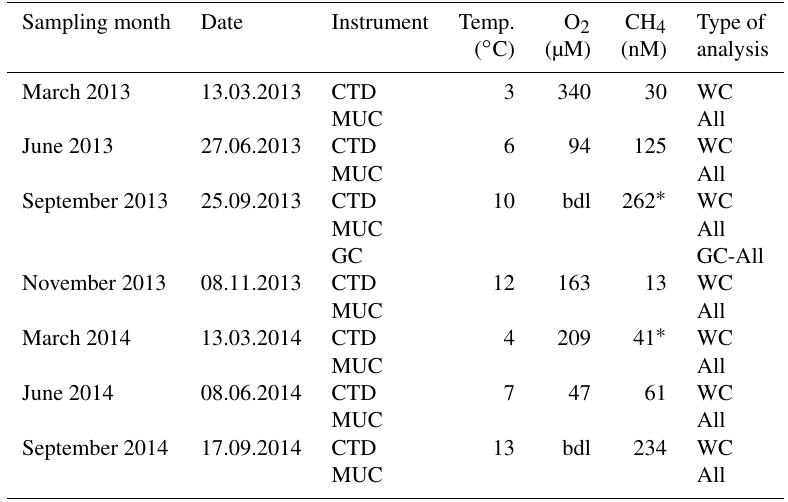
Table 1. Sampling months with bottom water ( ∼ 2m above the seafloor) temperature (Temp.), dissolved oxygen (O 2 ) , and dissolved methane (CH 4 )